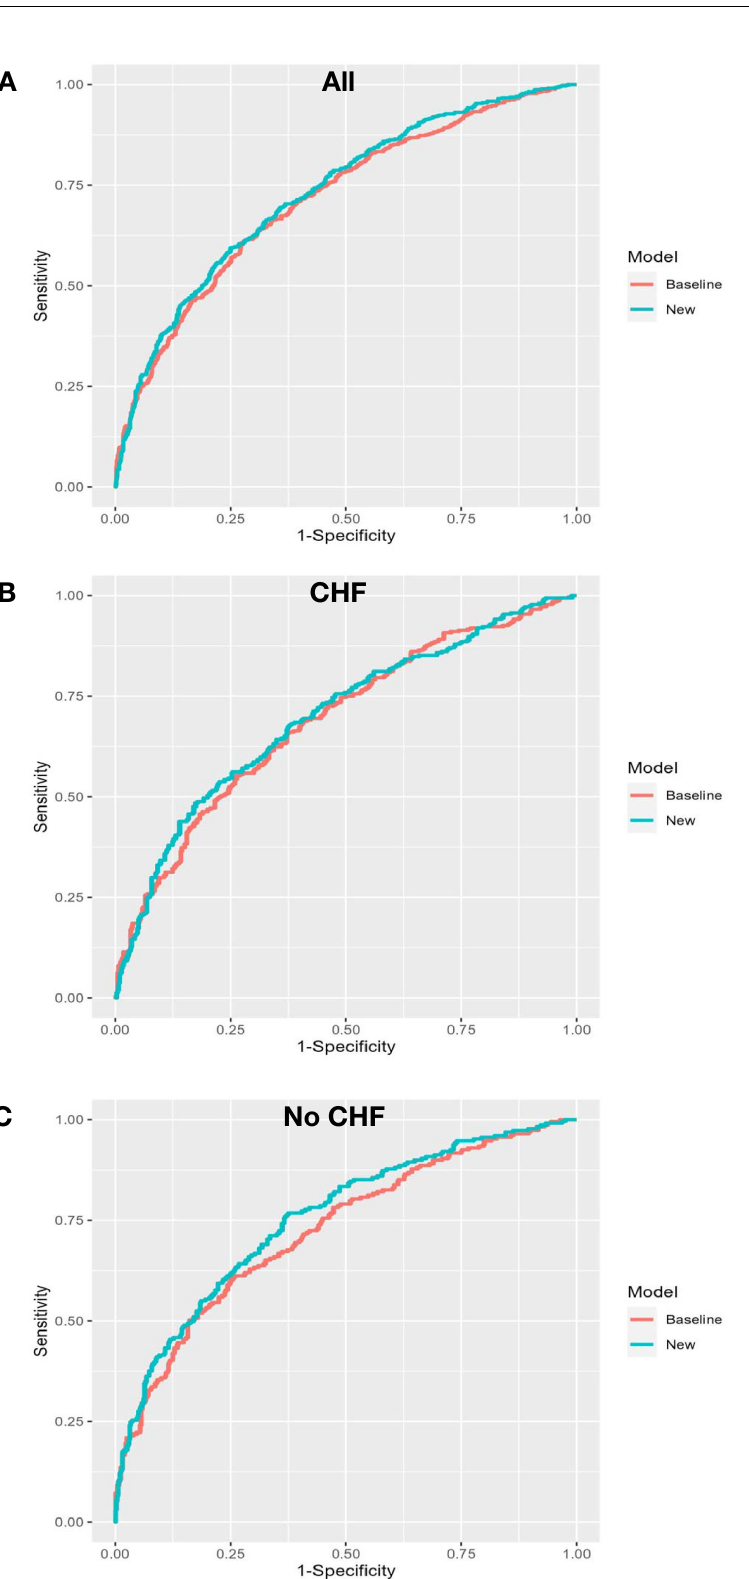
Fig 2. ROC curves. Sensitivity verse 1-Specificity. Dotted lines are baseline model RiskOP model, solid lines are the new model with addition of BNP. https://doi.org/10.1371/journal.pone.0277850.g002 PLOS ONE | https://doi.org/10.1371/journal.pone.0277850 November18,